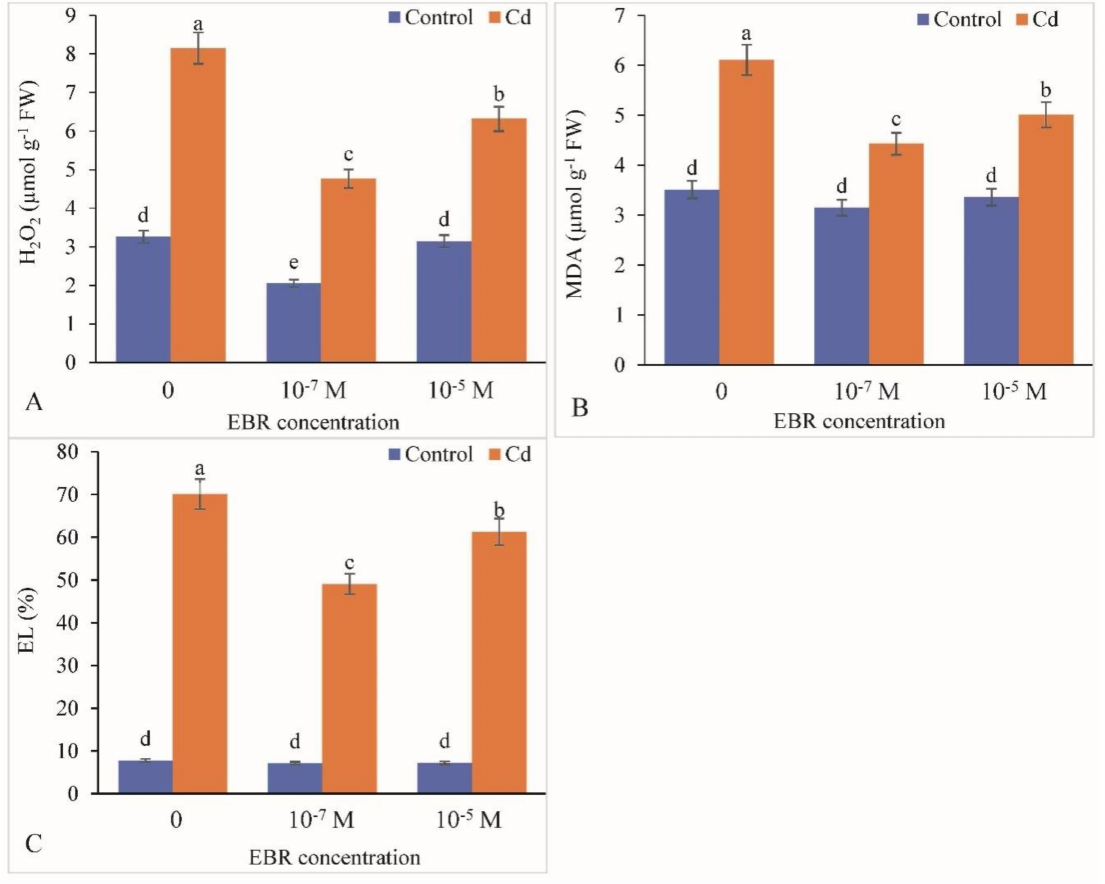
Figure 6. Supplementation of 24-Epibrassinolide regulates production of leaf ( A ) H 2 O 2 , ( B ) MDA and ( C ) EL in B. juncea under Cd (200 µ M) stress. Values with di ff erent letters above the bars are significantly di ff erent at each measured time point ( p < 0.05) (Mean ±